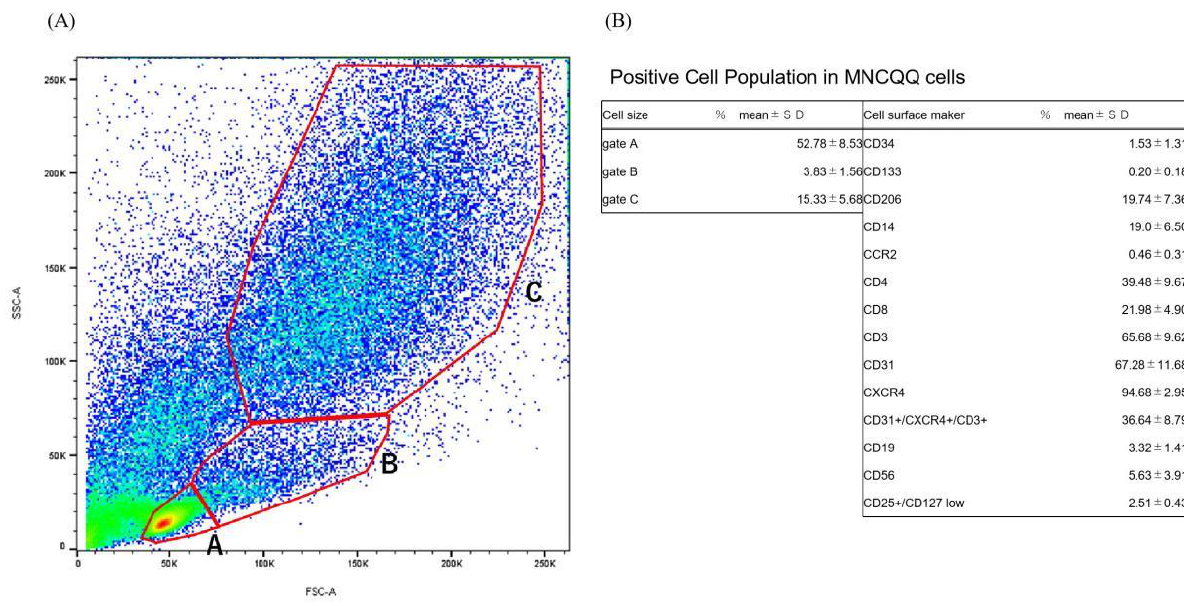
Figure 1. Flow cytometry analysis of MNCQQ cells. ( A ). Scatter diagrams of MNCQQ cells in flow cytometry. The red lines indicate the cellular-sized gates of lymphocyte (A), monocyte (B), or the larger cell (C). ( B ). The table shows cell positivity in MNCQQ cells. N = 5 volunteers. The investigated cell surface markers were as follows: hematopoietic stem cell (CD34 and CD133); M2 macro- phage (CD206); monocyte (CD14); M1 macrophage (CCR2); endothelial cell (CD31); T cell (CD4,